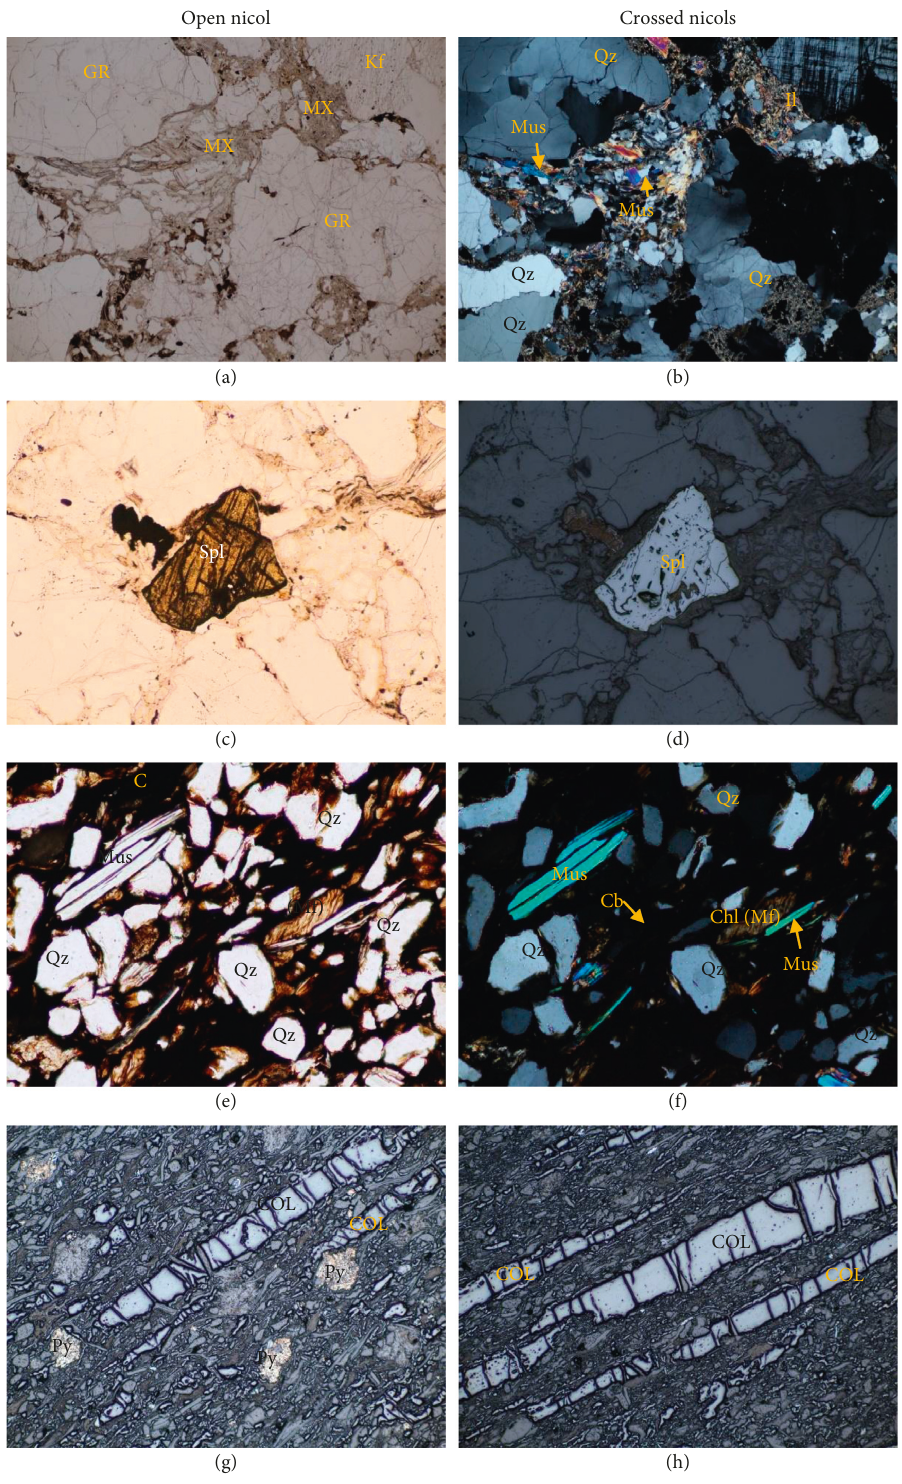
Figure 11: Microscopic images of Kaziwiziwi conglomerate (a, b, c, d) and Kaziwiziwi carbonaceous sandstone (e, f, g, h). GR: granites; MX: matrix; Mus: muscovite; Il: illite; Spl: sphalerite; Chl: chlorite; Py: pyrite; COL: coal. Widths of the images are 6.0mm for (a) and (b); 1.2mm for (c) and (d); 0.60mm for (e) and (f); and 2.5mm for (g) and